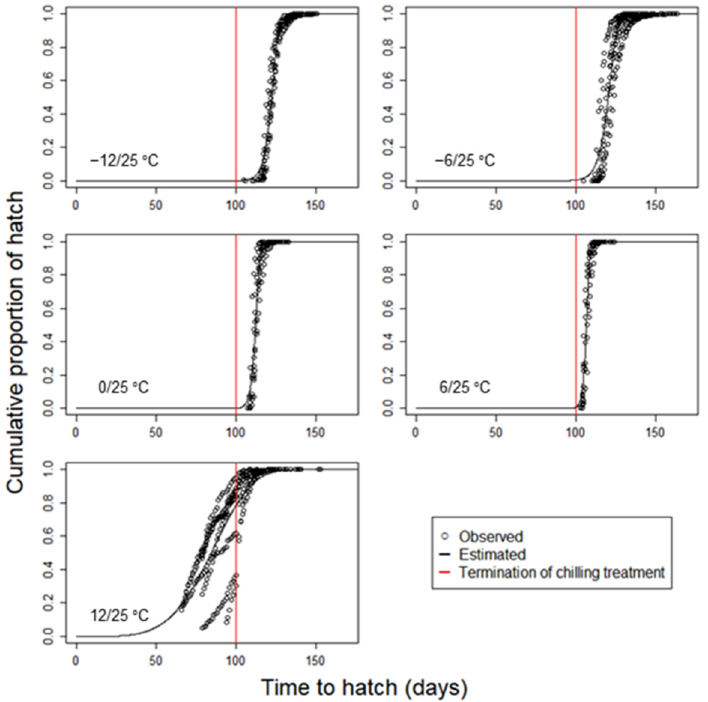
of the model, which represents the time of the 63.2 percentile of hatching (Table 3). The